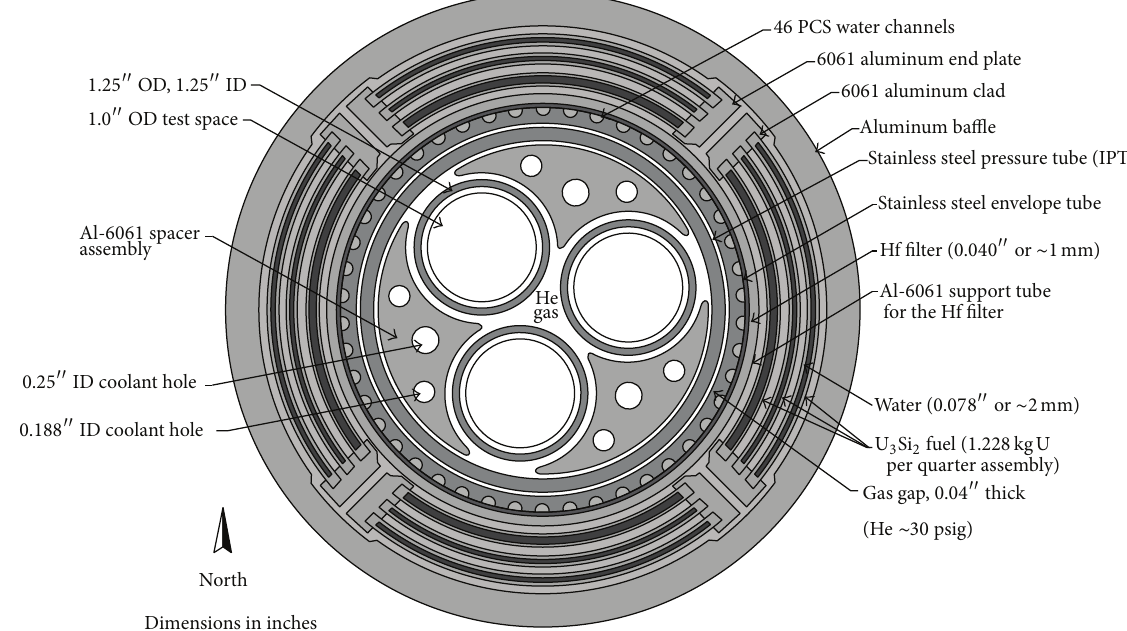
Figure 16: A graphical representation of the Gas Test Loop conceptual design [12].